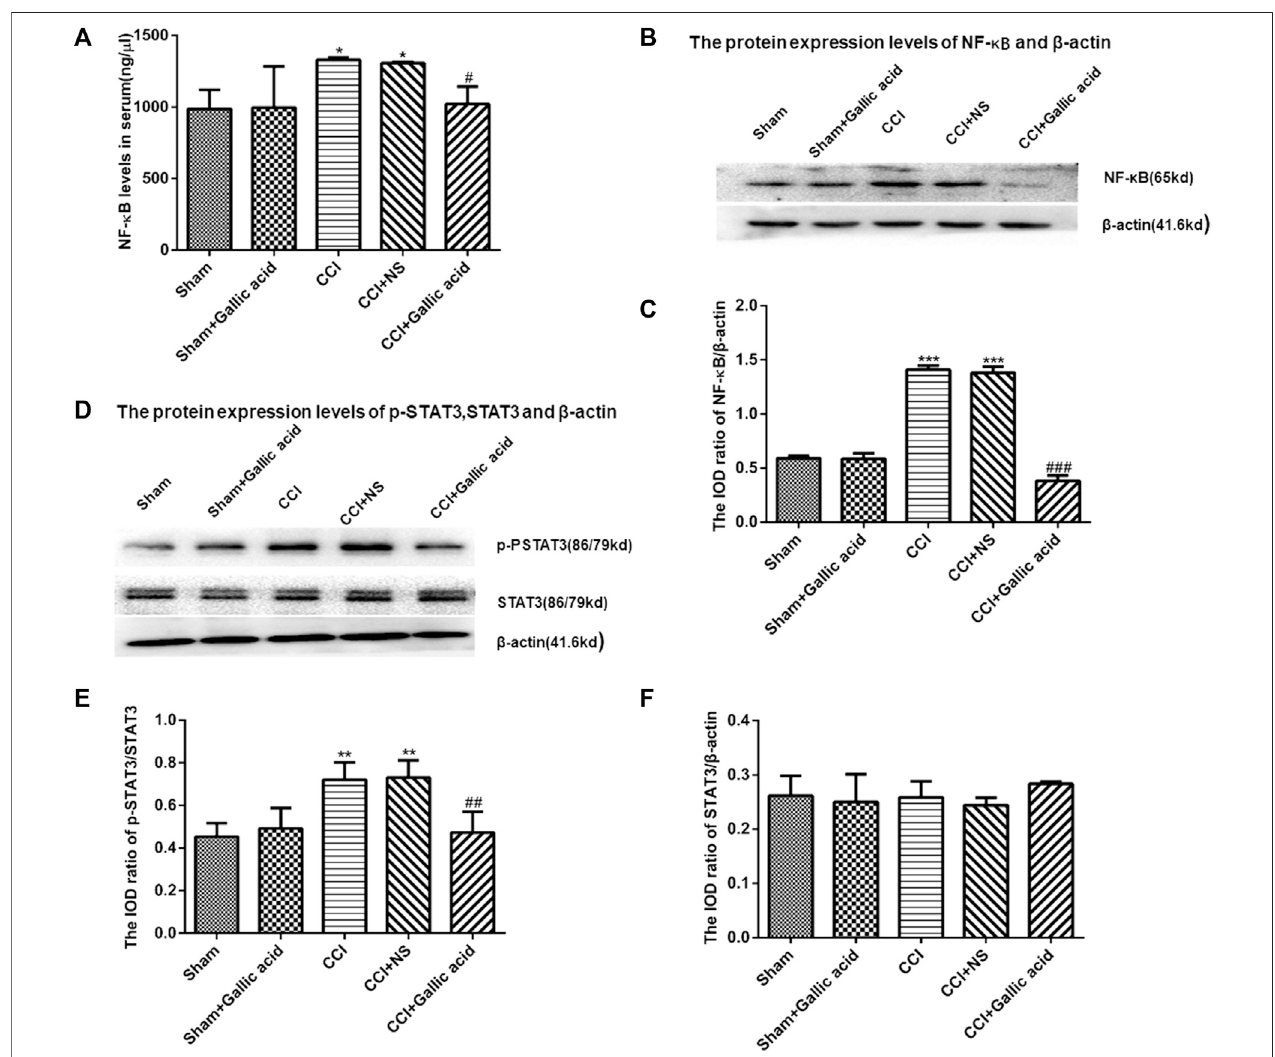
FIGURE 4 | The effectof gallic acidon the expression of NF- κ B and STAT3. (A). Expression ofNF- κ B in serum ofrats (F (4, 10) (cid:2) 8.226, p (cid:2) 0.3737). (B). The protein expressionofNF- κ B and β -actin inthe DRG was detectedbyWestern blotting. (C). The relative protein expressionofNF- κ B (F(4, 10) (cid:2) 217.4, p < 0.001). (D). The protein expression of p-STAT3, STAT3, and β -actin in the DRG was detected by Western blotting. (E). The relative protein expression of p-STAT3 (F (4, 10) (cid:2) 10.05, p (cid:2) 0.0016). (F). The relative protein expression of STAT3 (F (4, 10) (cid:2) 1.188, p (cid:2) 0.3737). Each group consisted of eight rats. One-way ANOVA was used to detect the expression of NF- κ B and STAT3. Data are presented as mean ± SEM. ** p < 0.01 and *** p < 0.001versus Sham group, ## p < 0.01 and ### p < 0.001 versus the CCI group.